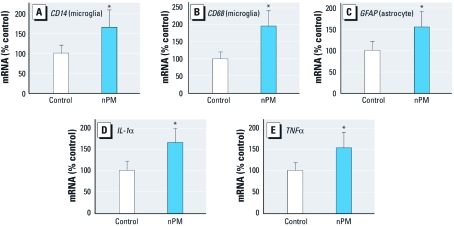
In vivo exposure of mice to chronic nPM induced
inflammatory responses, shown by qPCR analysis of cerebral cortex mRNA of mice
exposed to reaerosolized nPM at levels equivalent to peak vehicular traffic for 10
weeks, 3 days/week, 5 hr/day, as described in “Materials and Methods.” In cerebral
cortex, nPM increased mRNA levels of innate immune receptor CD14 by 75%
(A); the microglial marker CD68 by 100% (B); the astrocytic
marker GFAP by 50% (C); and the two proinflammatory cytokine mRNAs
IL-1α (D) and TNFα (E) (n = 7 cortices per
group). *p < 0.05, compared with control air-exposed mice.